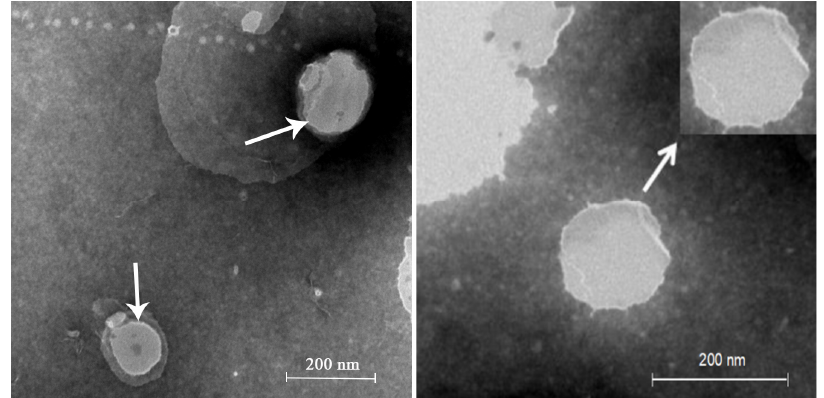
Figure 1. TEM micrographs of LAL nanoparticles.